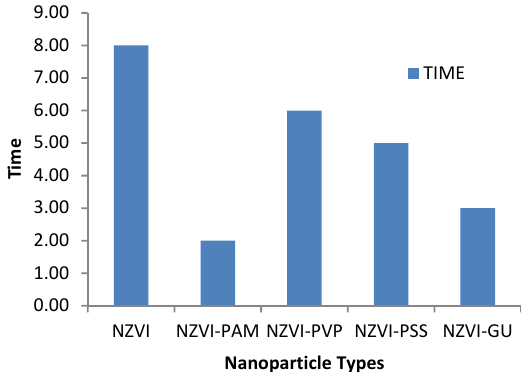
Fig.14. Optimum times for Cr(VI) removal from solutions using bare and different polymer stabilized ZVINs